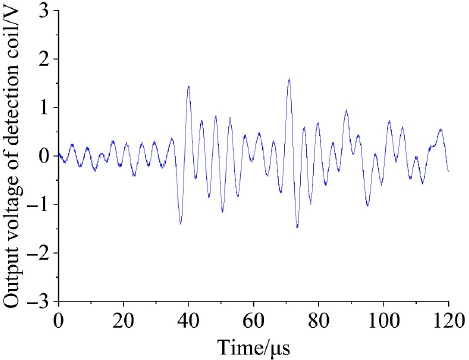
Figure 17. The details of the waveform acquired by the oscilloscope when adjacent magnetic fi eld coils are at the minimum interval